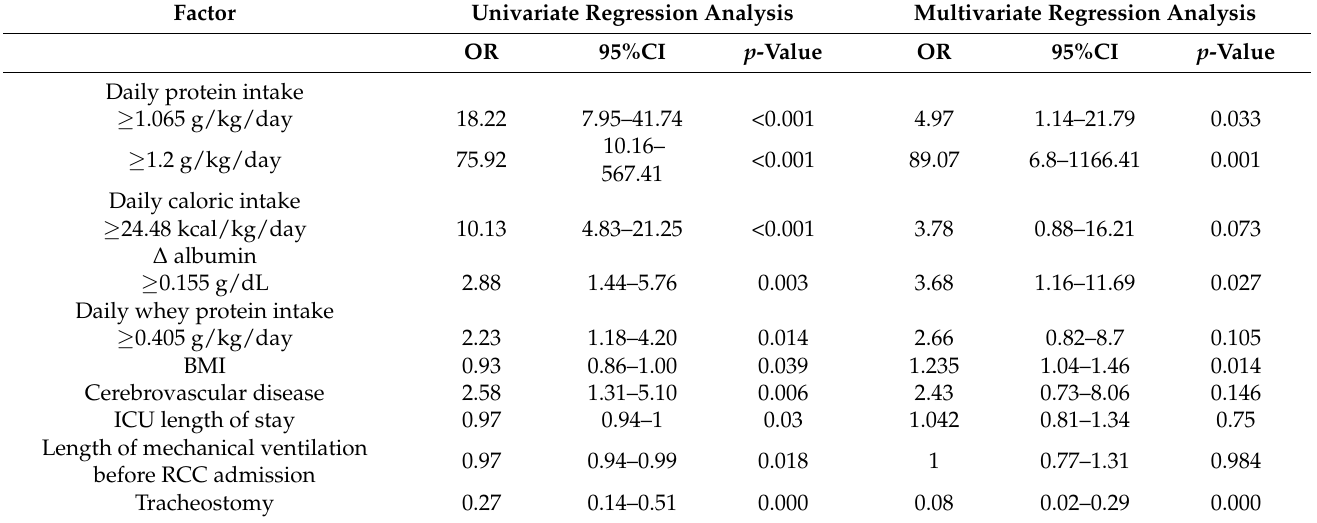
Table 2. Factors associated with weaning outcomes.